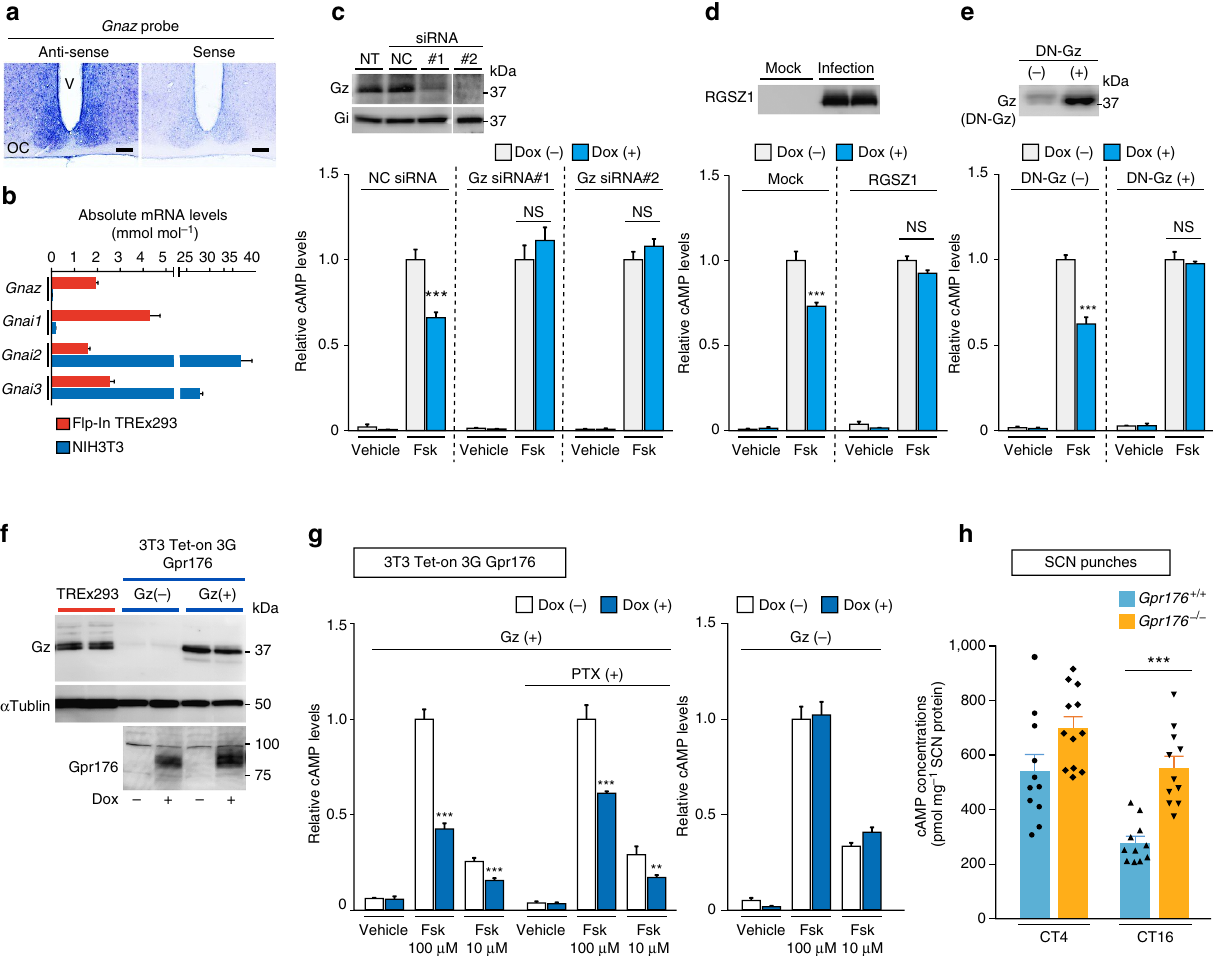
Figure 4 | Gpr176 couples to Gz. ( a ) In situ hybridization of the gene encoding Gz ( Gnaz ) in the mouse SCN using a digoxigenin-labelled gene-specific probe. Scale bar, 100 m m. ( b ) Expressions of the genes encoding Gz ( Gnaz ), Gi1 ( Gnai1 ), Gi2 ( Gnai2 ) and Gi3 ( Gnai3 ) in TREx293 (red) and NIH3T3 (blue) cells. Values (means ± s.e.m.) were determined by qRT–PCR and normalized to those of the ribosomal phosphoprotein P0 (Rplp0)-encoding gene ( n ¼ 3). ( c ) Interference of Gpr176-mediated cAMP repression by knocking down Gz protein with two different siRNA mixtures. For simplicity, Flp-In TREx293 cells bearing only Gpr176 were used (no concomitant Vipr2 expression in this assay). Cells were transfected with siRNAs for 96h, with or without Dox for the final 24h, and stimulated by Fsk (100 m M). Transfection was also performed with a negative-control siRNA (NC). Immunoblots show efficient knockdown of Gz. There was no off-target effect on Gi. NT, non-transfected cells. cAMP levels are plotted relative to those of Fsk-stimulated uninduced cells. Data are the mean ± s.e.m. of at least two independent experiments with three replicates each. *** P o 0.001 in comparison with the control stimulated group. NS, not significant. ( d ) Inactivation of Gpr176-mediated cAMP reduction by RGSZ1 coexpression. Cells were infected with lentiviruses encoding GFP (mock) or HA- tagged RGSZ1 and treated with or without Dox for 24h. Western blot shows delivered proteins (anti-HA). cAMP values in Fsk-stimulated (100 m M) and nonstimulated (vehicle) cells are shown as described in c . ( e ) Interruption of Gpr176-mediated cAMP reduction by coexpression of DN-Gz. DN-Gz was stably introduced into the cells, and Dox-treated or non-treated cells were stimulated with Fsk (100 m M) or vehicle. Western blot (anti-Gz) shows the predominance of DN-Gz over the endogenous protein. cAMP values are expressed as described in c . ( f ) Generation and western blot confirmation of NIH3T3-based Tet-inducible Gpr176 cell lines with or without stable expression of Gz. Cells were treated with or without Dox and immunoblotted for indicated proteins. Note that Gz is scant in parental NIH3T3 cells. ( g ) cAMP repressive activities expressed by Gpr176 in NIH3T3 Gz( þ ) cells. Dox-treated or non-treated cells were stimulated with Fsk or vehicle. Where specified, cells were treated with PTX for 16h before assay. cAMP values are expressed as described in c . ( h ) cAMP levels in the SCN of Gpr176 þ / þ and Gpr176 (cid:2) / (cid:2) mice at CT4 and CT16 in DD. SCN punches taken from mice were subjected to cAMP quantification by using a cAMP-specific enzyme immunoassay kit. Each data point represents a single animal. Bars indicate means ± s.e.m. for Gpr176 þ / þ CT4 ( n ¼ 11), Gpr176 (cid:2) / (cid:2) CT4 ( n ¼ 12), Gpr176 þ / þ CT16 ( n ¼ 11), and Gpr176 (cid:2) / (cid:2) CT16 ( n ¼ 11). *** P o 0.001, two-way ANOVA with Bonferroni post hoc